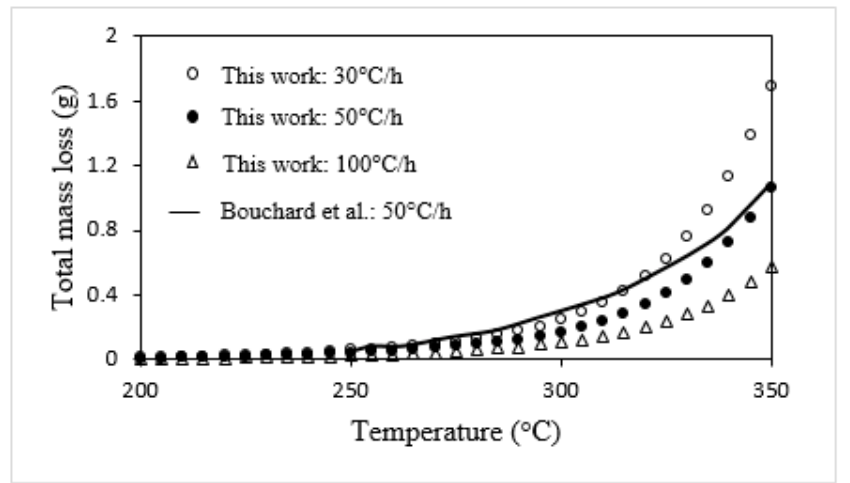
Figure 8. Effect of heating rate on total mass loss during heat treatment of a 50 g mass pitch in temperature range below 350 ◦ C. Solid line: experimental data obtained by Bouchard et al. [28] at 50 ◦ C/h; points: predictions in this work (using φ i s : 1 and carrier gas flow rate: 2300 cm 3 /min).